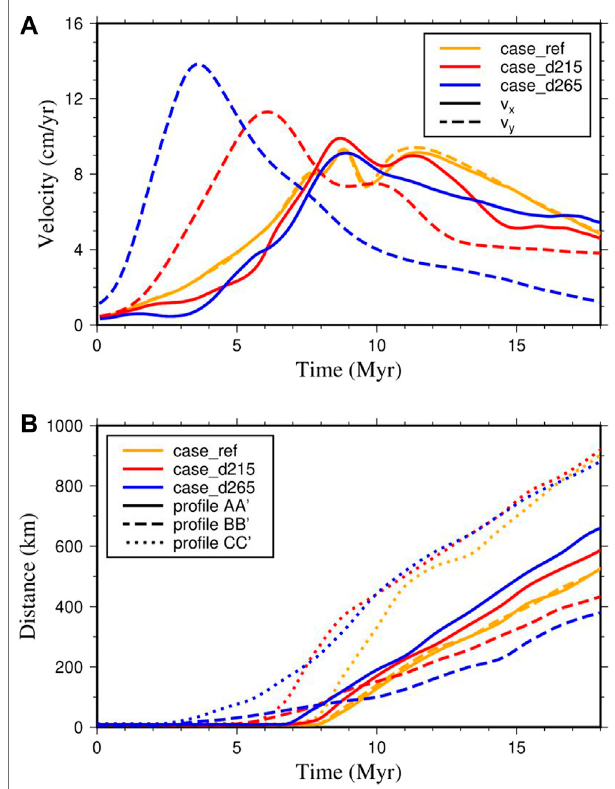
FIGURE 7 | (A) The velocities of the subducting plate in case_ref (orange), case_d215 (red), and case_d265 (blue). The solid line and dashed line represent the velocities of the subducting plate in the X and Y directions, respectively. (B) The migration distances of the trench along pro fi les AA ’ (solid line), BB ’ (dashed line), and CC ’ (dotted line) in Figure 2A . Orange, red, and blue colors show the results of case_ref, case_d215, and case_d265,